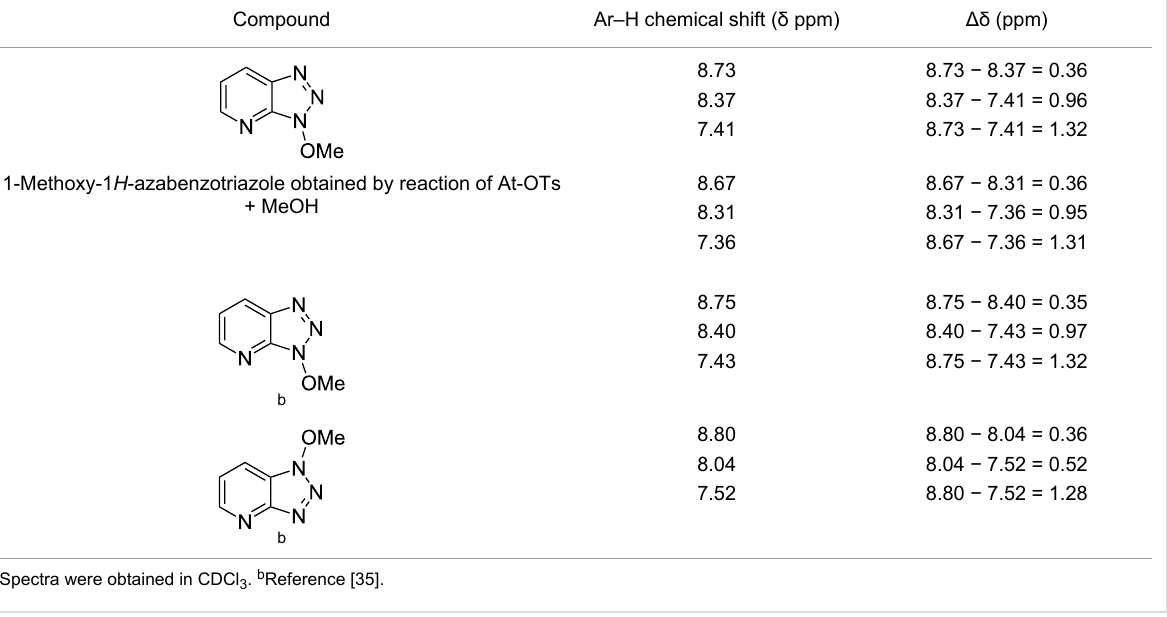
Table 4: Reactions of various alcohols with